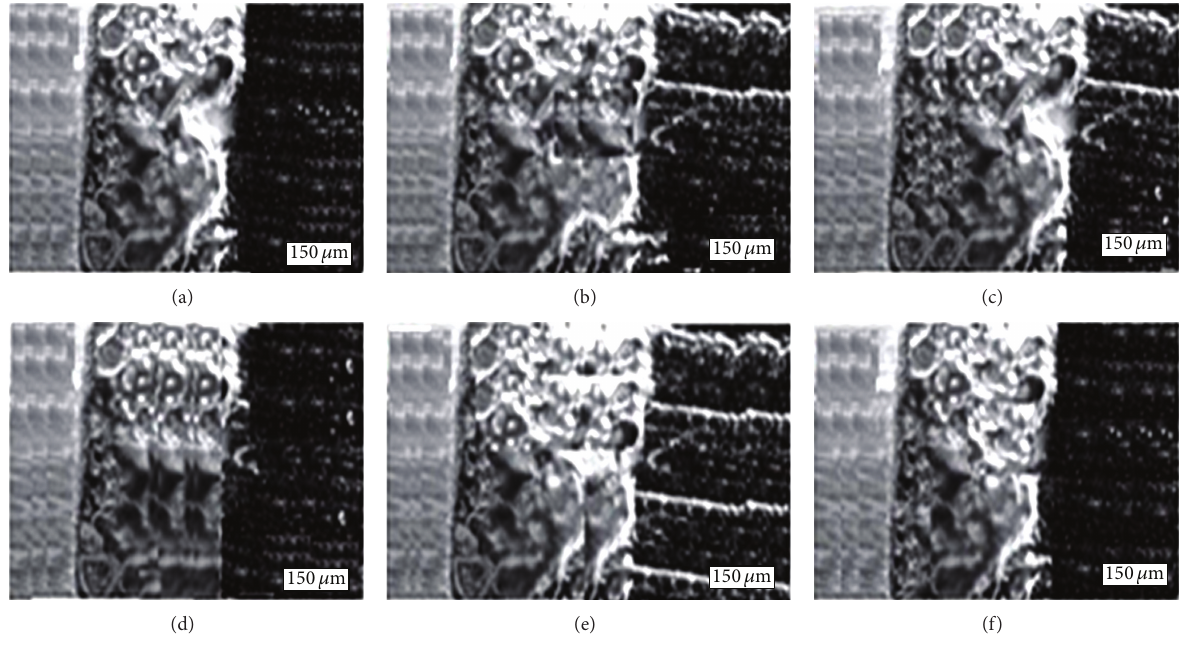
Figure 3: Microstructure of joint seam width of 316 L stainless steel and PET